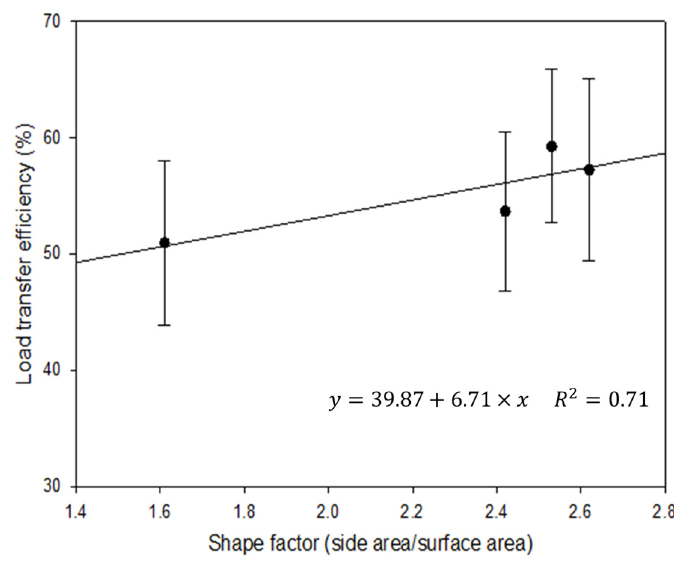
Figure 6. Relationship between LTE and shape factor (joint filling = 100%). Figure 7 shows the LTE measurements of the rectangular blocks according to construc- tion pattern. The slope of the linear regression trend line was similar in all cases. A slight difference in the LTE by the construction pattern is measured. LTE is determined according to the joint condition. Since the construction pattern is independent of the joint condition, it is determined not to have an effect on the LTE.